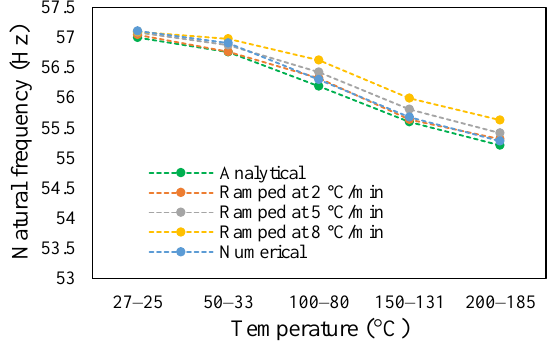
Figure 14. Natural frequency of 1 mm crack depth in non-uniform temperature.